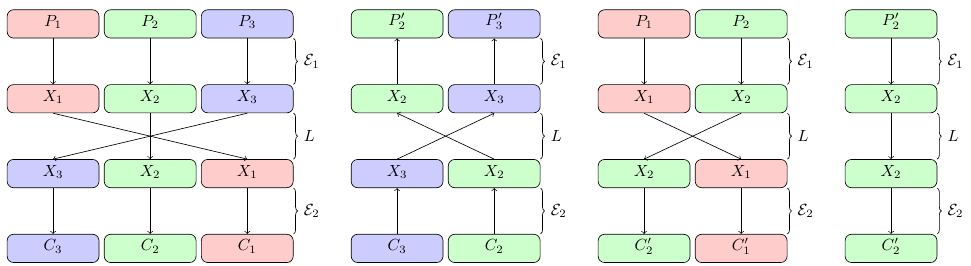
Figure 10: Attack against Π rev , as described in Lemma 9. The adversary A makes the four 2 queries shown in this diagram, and returns 1 if the two values labelled C 0 agree. Shown in 2 the diagram are the internal variables corresponding to this in the real case, demonstrating that the collision will always occur, an event that almost never occurs in the ideal